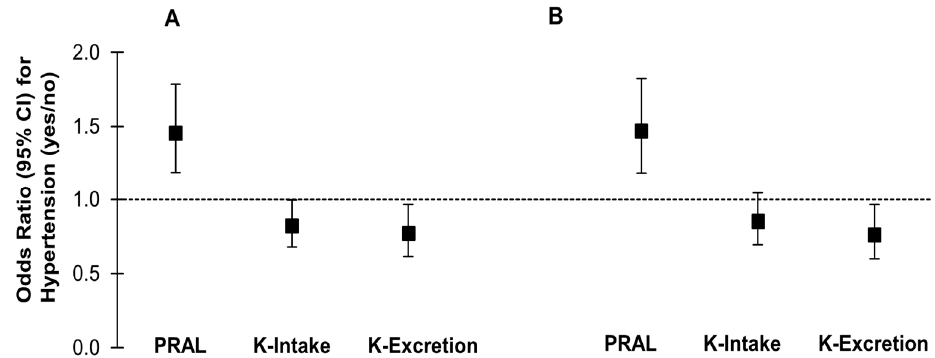
Figure 1. Odds ratios (95% CI) for hypertension (yes/no) comparing the highest (T3) with lowest (T1) tertiles of potential renal acid load (PRAL), food frequency questionnaire-derived potassium intake (K-Intake), and potassium excretion in the total study sample (6765) ( A ) and in a subsample ( n = 5854) ( B ) excluding participants with impaired renal function. Odds ratios were calculated using logistic regression models adjusted for age, sex, and body mass index, size of blood pressure cuff, fasting duration (> or <8 h), smoking status, natrium excretion, alcohol intake, estimated glomerular filtration rate, serum glucose, and total cholesterol. CI, confidence interval.